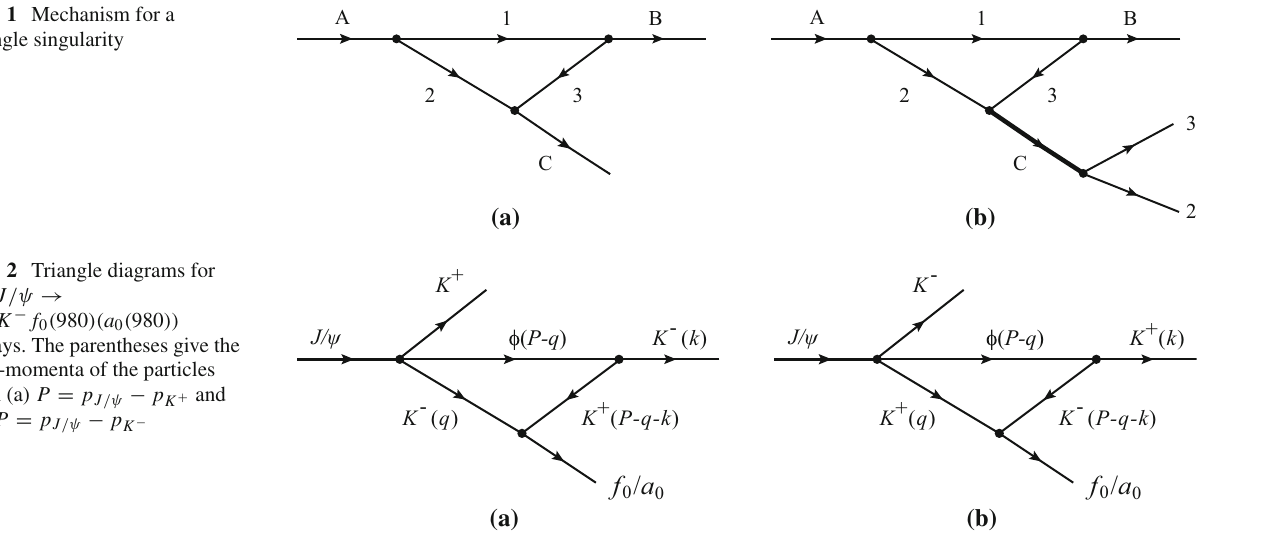
Fig. 1 Mechanism for a triangle singularity